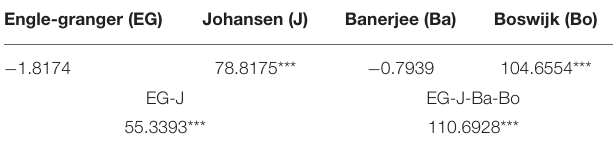
TABLE 5 | Bayer-Hanck cointegration analysis.